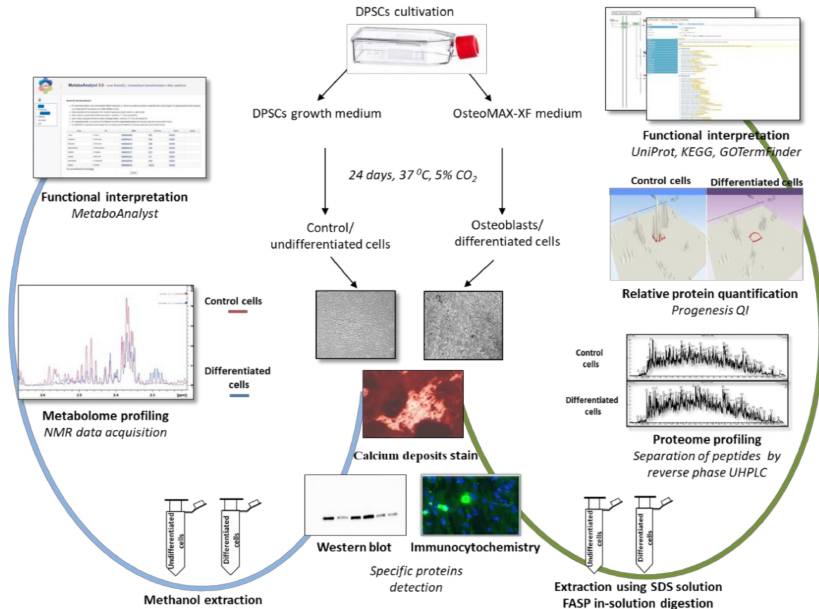
Figure 1. Experimental design—analytical workflow. We followed undifferentiated and differentiated human dental pulp stem cells (DPSCs). Osteogenic differentiation was verified by calcium deposits stain, Western blotting, and immunocyto- chemistry. Proteins extracted from three biological replicates were digested using filter-aided sample preparation (FASP). Following that, we directly quantified proteins by mass spectrometry upon comprehensive two-dimensional separation of analytes. Metabolites were directly quantified by nuclear magnetic resonance (NMR). Dedicated KEGG, GOTermFinder, and MetaboAnalyst tools accompanied with enrichment analysis were used for revealing the biological meaning of the extensive dataset.